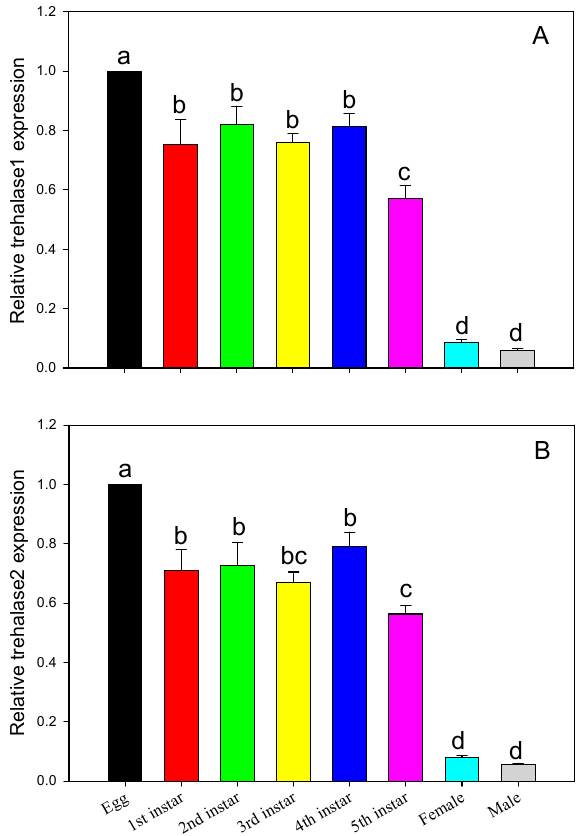
Figure 8. Expression patterns of trehalase 1 ( A ) and trehalase 2 ( B ) in D. citri across different developmental stages. The values shown are means + SE. Different letters indicate significant differences in gene expression across different developmental stages ( p < 0.05).